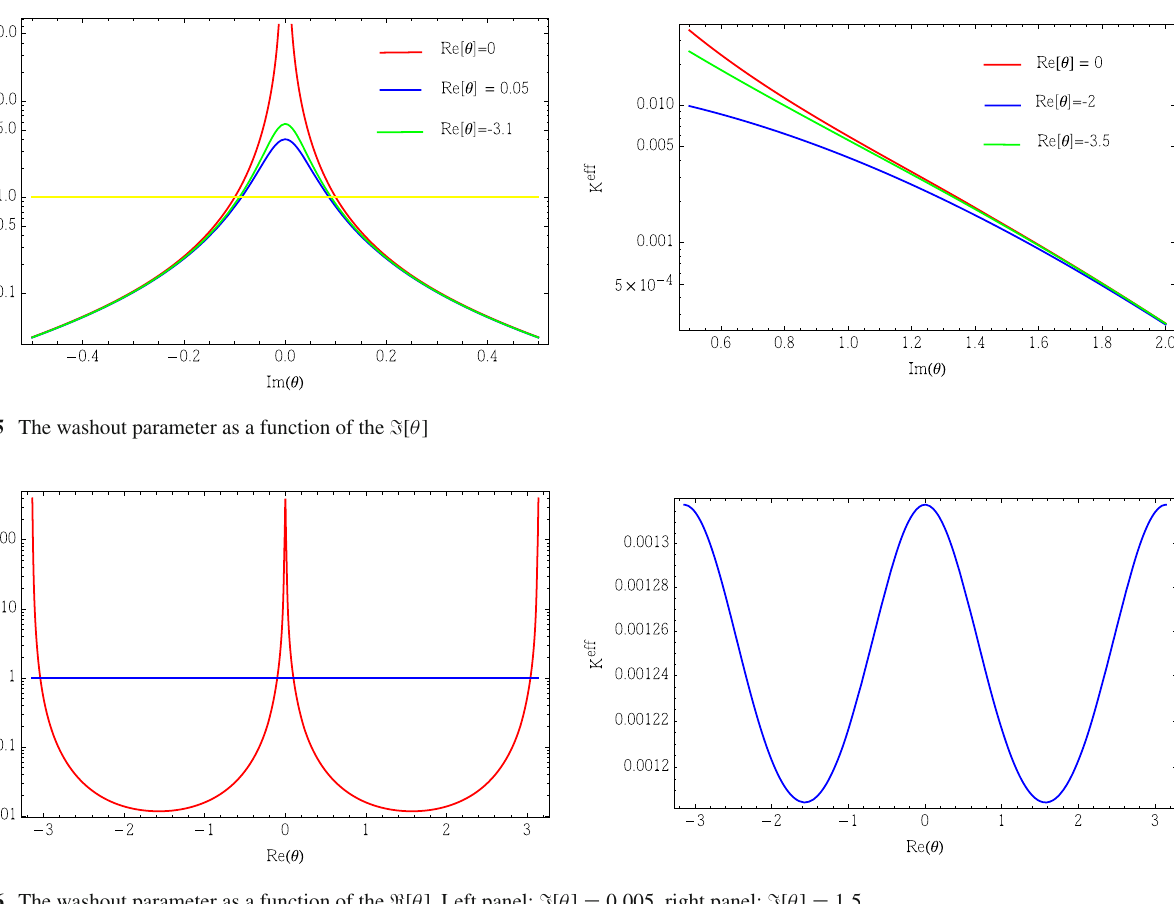
Fig. 6 The washout parameter as a function of the (cid:15)[ θ ] . Left panel: (cid:11)[ θ ] = 0 . 005, right panel: (cid:11)[ θ ] = 1 . 5